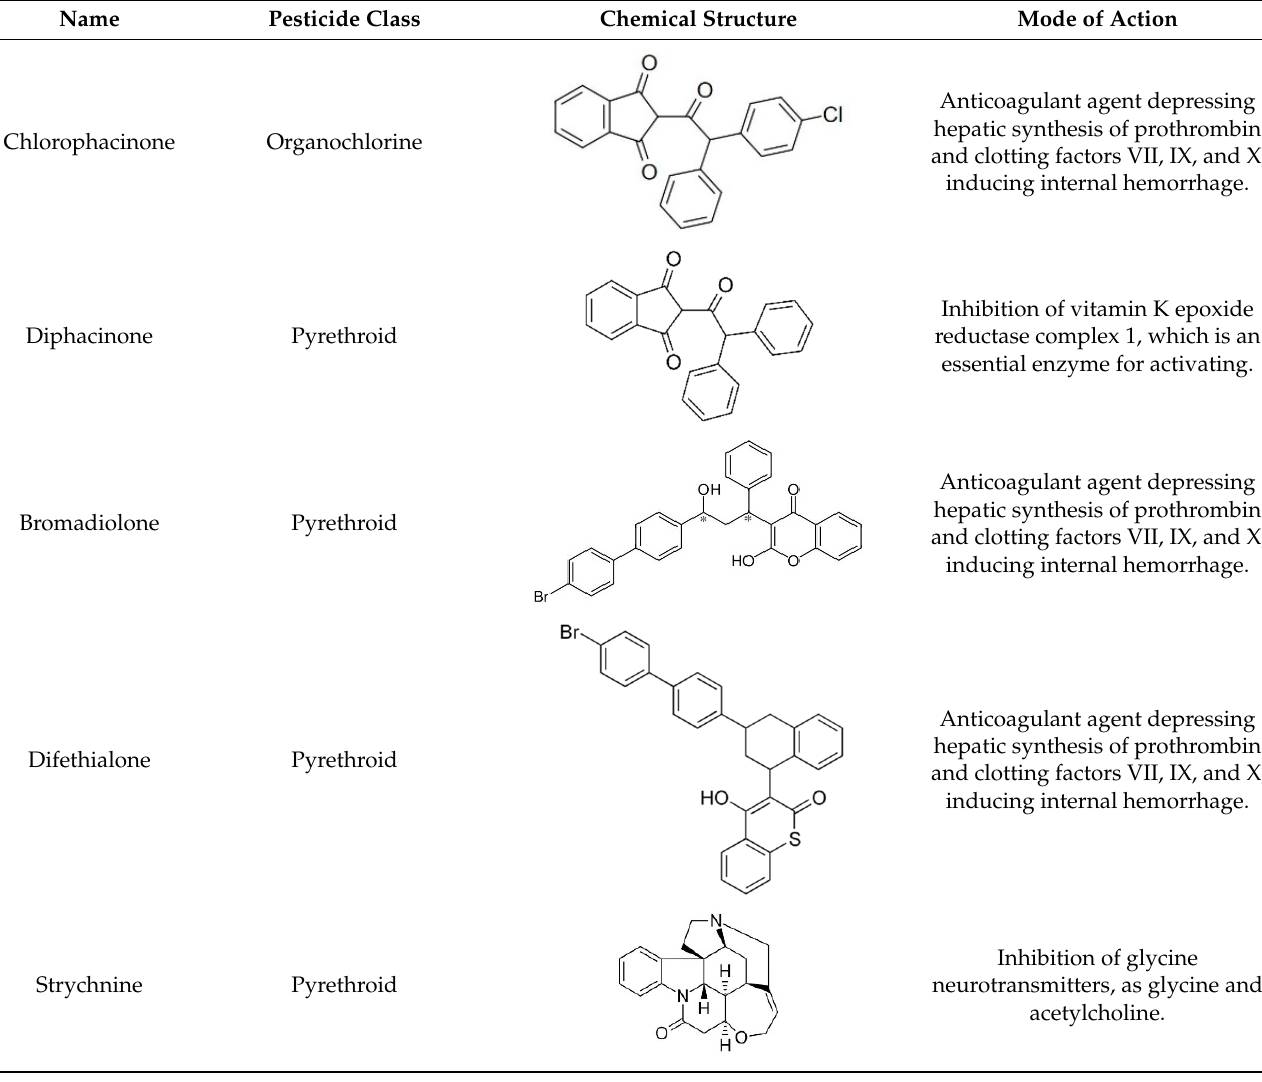
Table 5. Classification of the most common rodenticides.